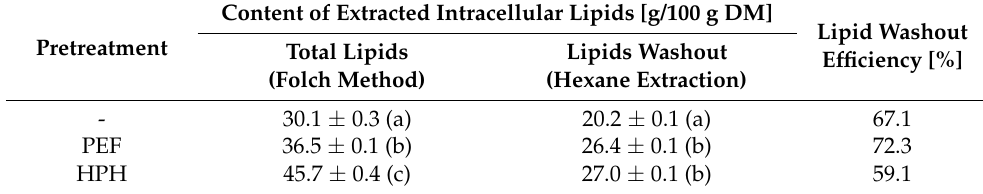
Table 4. Impact of HPH and PEF on yeast